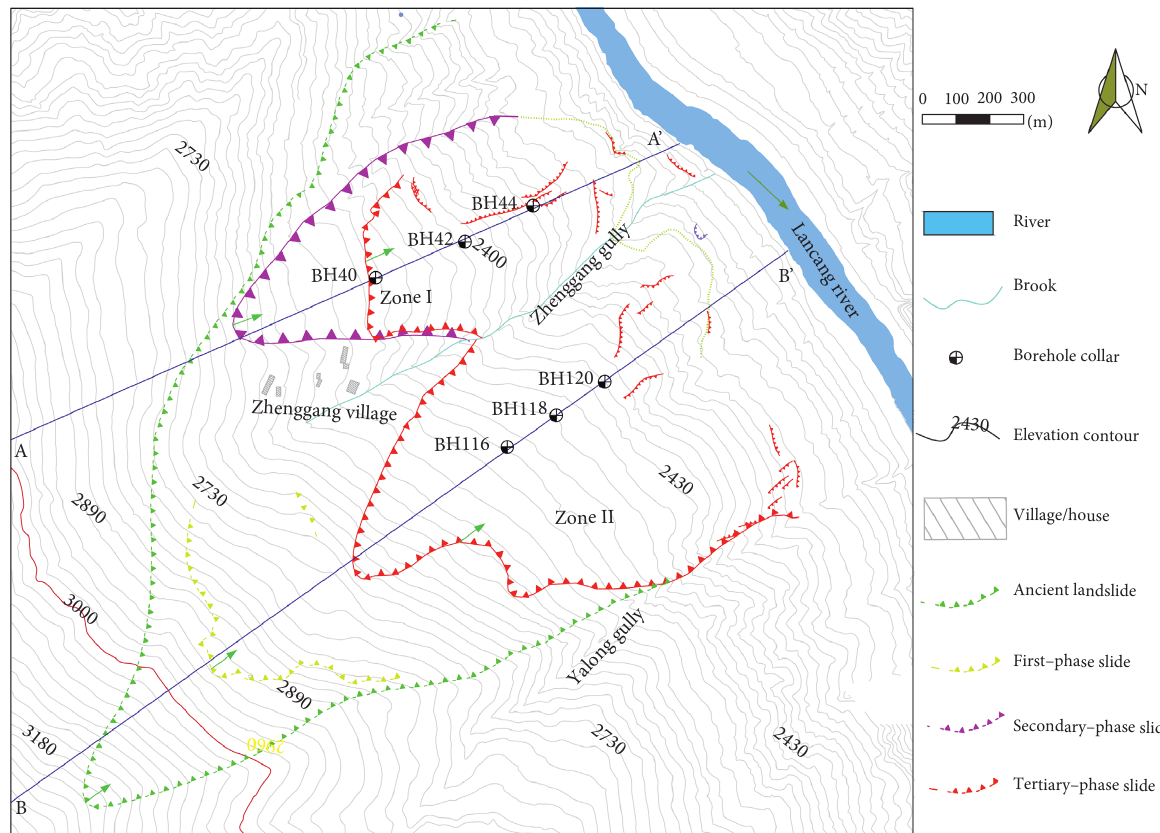
Figure 2: Planar morphology and regional characteristics of the Zhenggang